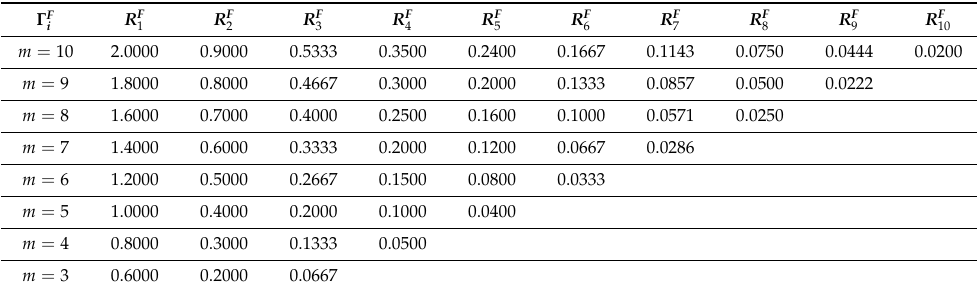
Table 6. The constant values of the performance of options/alternatives based on the number of options/alternatives.